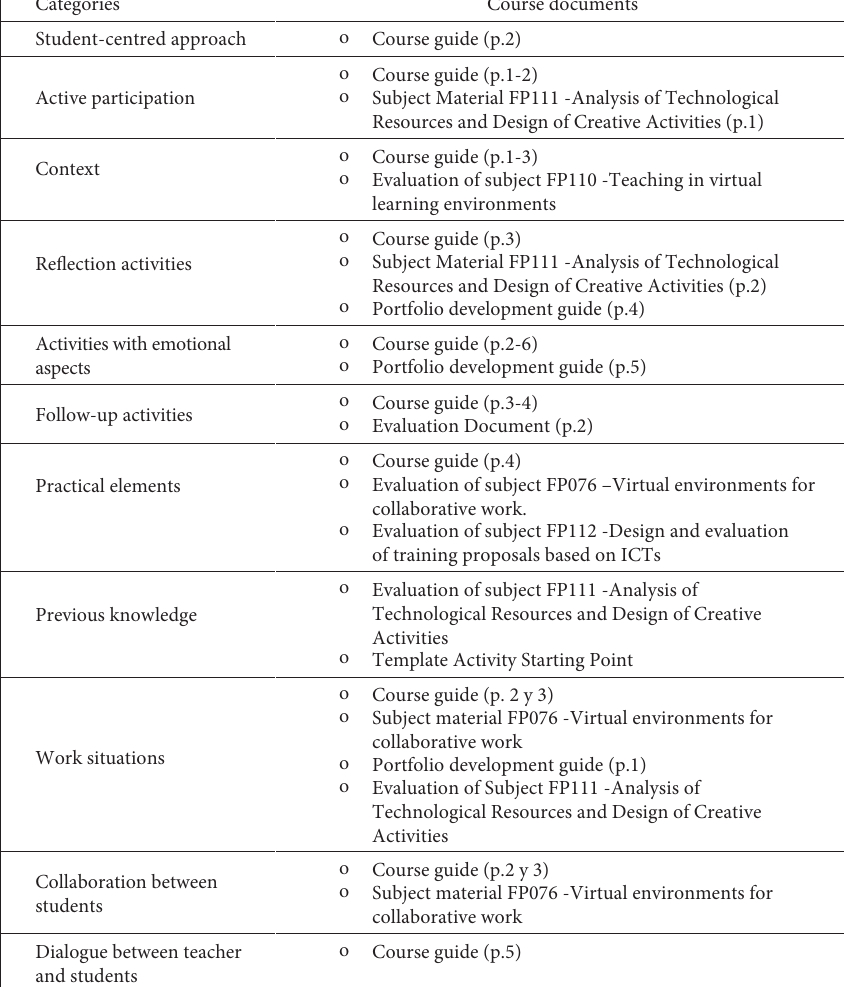
Figure 3: Documentary source for each of the categories.